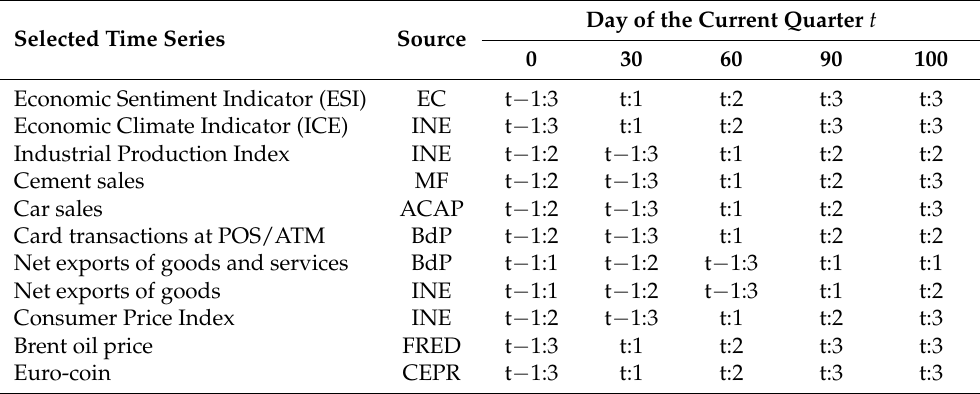
Table 1. Number of months of data available at days 0, 30, 60, 90 and 100 of the current quarter t . Selected Time